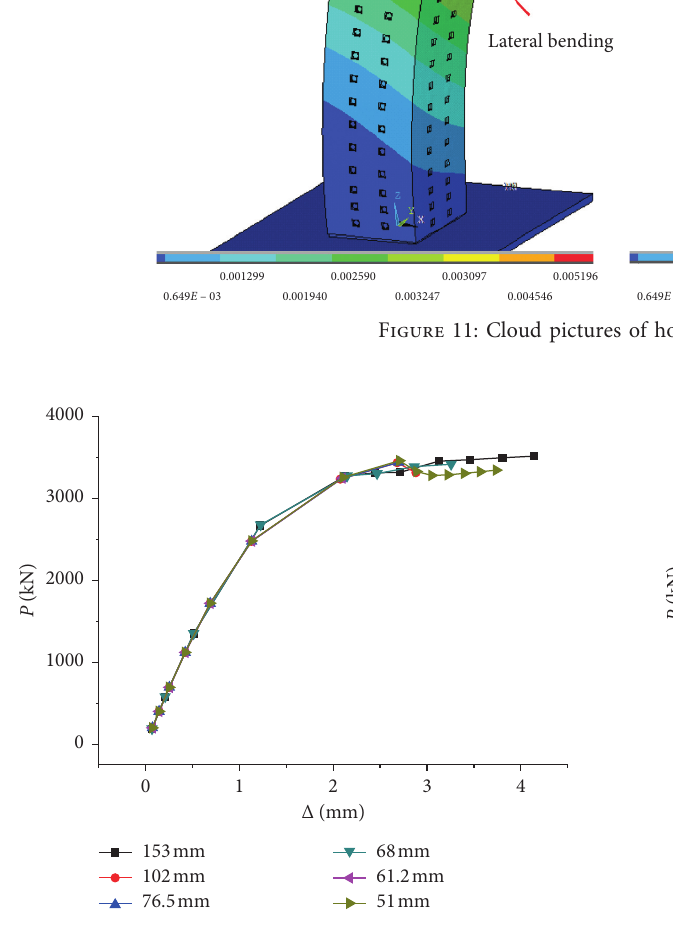
Figure 13: Influence of longitudinal bar diameter on specimen